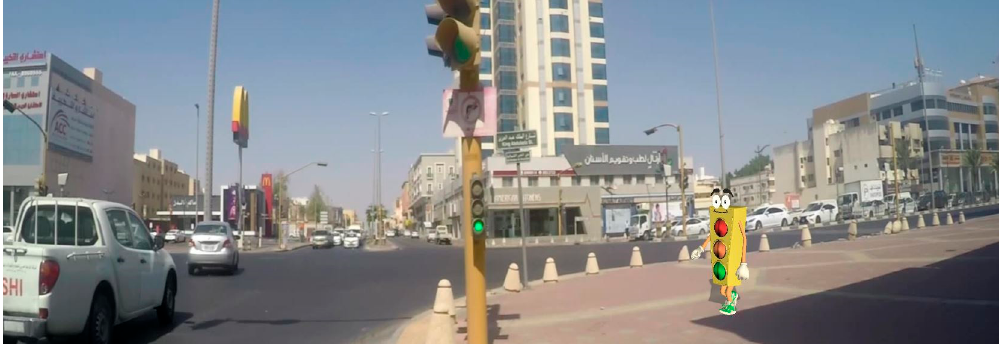
Figure 5. Example of the mixed reality setup.